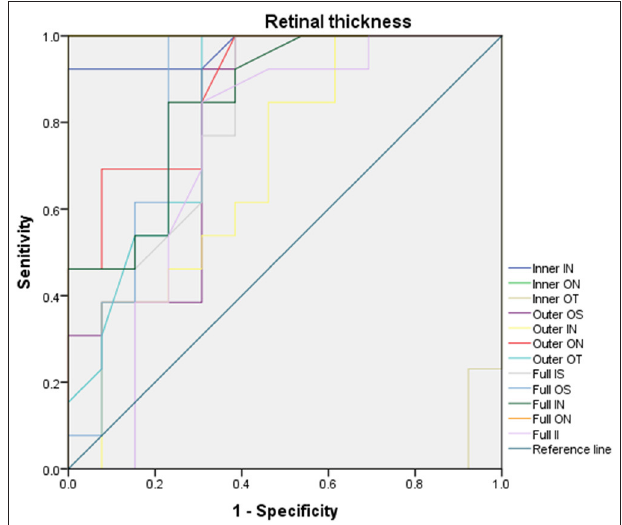
FIGURE 4 | ROC curve analysis of RT. In ON subregion, the areas under the curve of the inner retinal thickness, outer retinal thickness and the whole retinal thickness were 1.0 (95% CI: 1.0), 0.882 (95% CI: 0.715–0.963), and 1.0 (95% CI: 1.0). In the IN area, the areas under the curve of external retinal thickness and full retinal thickness were 0.973 (95% CI: 0.916–1.0), 0.698 (95% CI: 0.491–0.905), and 0.852 (95% CI: 1.0), respectively, the minimum area under ROC curve of RT in OT area is 0.018 [95% confidence interval (CI): 0–0.059]. ROC, receiver operating characteristic; CI, confidence interval; RT, retinal thickness; IS, inner superior; OS, outer superior;IN, inner nasal; ON, outer nasal; II, inner inferior; OI, outer inferior; IT, inner temporal; OT, outer temporal; C,